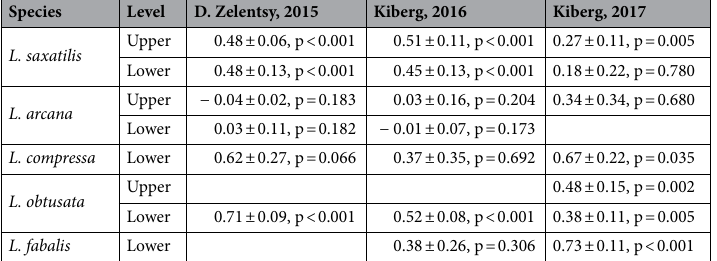
preferential mating with conspecific females and with conspecific males, the latter being evident in the upper littoral zone. Males of L. fabalis apparently preferentially mated with conspecific females (Supplement S8), which cor- responds to a high FI value of these males and a significant precopulatory isolation within the “obtusata” group (Table 5). In the “saxatilis” group, males of L. compressa had a high FI value (Table 4) and were attracted to conspecif- ics according to pCCA results (Supplement S8). Although members of the “saxatilis” group in general showed low or non-significant I PC values, on two occasions precopulatory isolation between L. compressa males and L. saxatilis was significant (Table 5). A peculiar mating pattern was found in the species pair L. arcana + L. saxatilis . Three categories of active partners were taken into account: L. saxatilis (1 row of penial glands), L. arcana (2 and more rows of penial glands) and 1.5 rows-males (presumably hybrids between L. saxatilis and L. arcana ; for details see Methods sec- tion and 59 ). Males of all the three categories exhibited a similar pattern of copulatory activity, being most often found in pairs with L. saxatilis females. This is why these three categories of males grouped very closely on pCCA biplots in both the upper and the lower intertidal (Fig. 4). While L. saxatilis males had moderately high FI values (Table 4), L. arcana males had negative FI values in four of the five cases, which implies more rare pairing with conspecific females than expected based on random encounters. Actually, out of the 13 pairs of L. arcana males with mature females, 12 were with L. saxatilis females and only one with L. arcana female. Similarly, males of L. saxatilis were mainly recorded in pairs with females of L. saxatilis , (82 of 86 pairs) and only rarely with females of the other species (2 pairs with L. arcana , 1 with L. compressa , 1 with L. fabalis ; Table 2). The FI values for